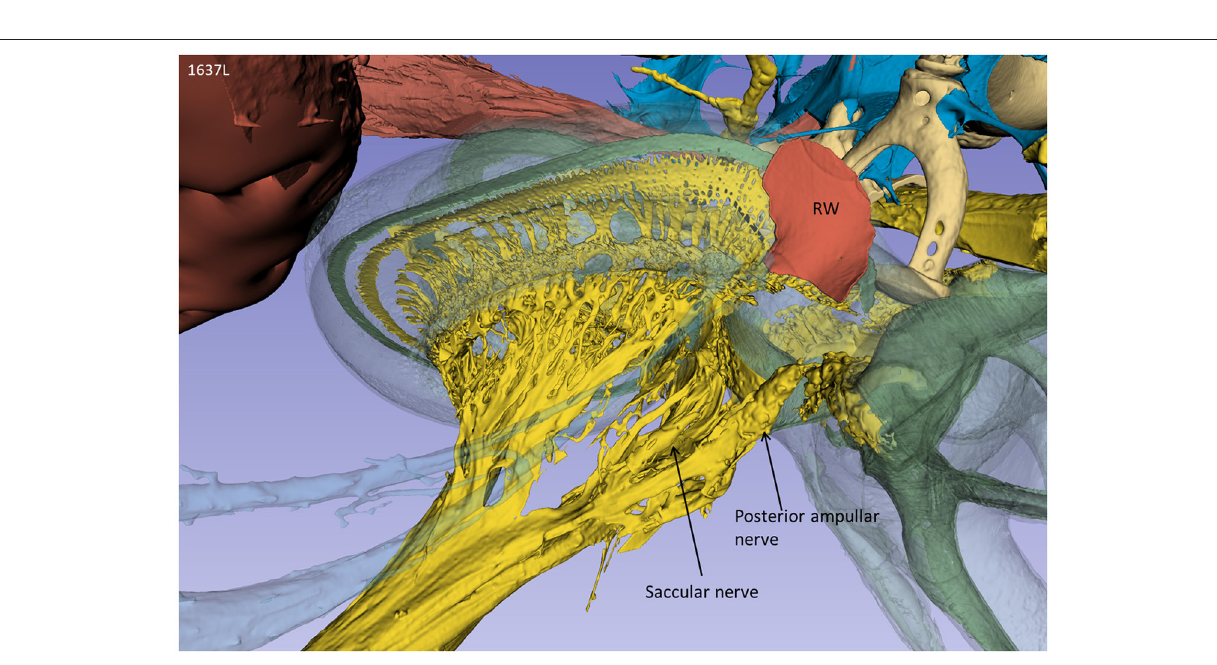
Frontiers in Neurology |